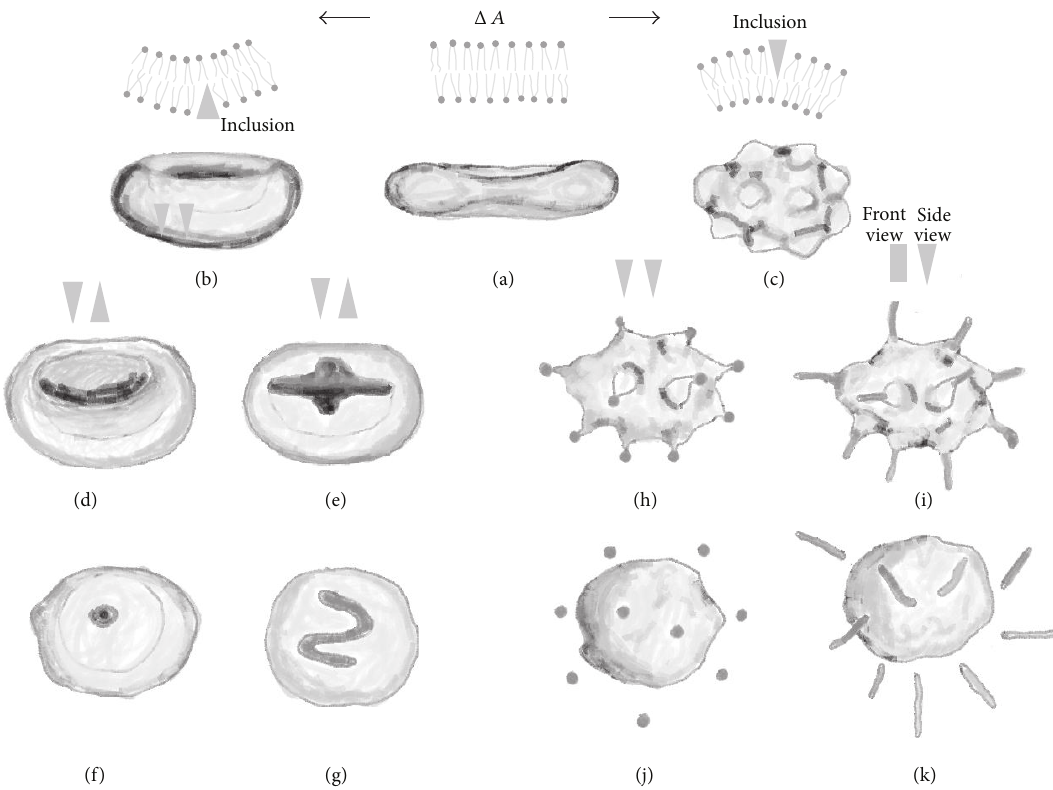
Figure 4: Suggested mechanism of erythrocyte shape change due to continuous interaction of exogenous substance with the membrane. Initially discocytic shape (a) transforms due to inclusions seeded by exogenous substance. If the inclusion resides in the outer layer, the area oftheouterlayerexpandsrelativelytotheareaoftheinnerlayer(thedifferencebetweentheareasoftheouterandtheinnerlayer Δ𝐴 increases) andthemembranewrinklesoutwardstoattainechinocyticshape(c).Iftheinclusionintercalatesintotheinnerlayer,theareaoftheinnerlayer expands relatively to the area of the outer layer ( Δ𝐴 decreases) and the membrane bends inwards to attain stomatocytic shape (b). The process is promoted by increasing the number of inclusions while the erythrocyte shape transformation depends on the shape of the inclusion. If the inclusion is isotropic (axisymmetric with respect to the axis perpendicular to the membrane surface) and favors strongly curved membrane regions, membrane buds that form on the tips of the echinocyte spicules have spherical shape (h) while the invagination of the stomatocyte is axisymmetric with respect to the geometrical axis of the cell (d). If the inclusion is anisotropic (nonaxisymmetric with respect to the axis perpendicular to the membrane surface, so that its front view differs from its side view) and favors strongly curved cylindrical membrane regions, the membrane buds that form on the tips of the echinocyte spicules have tubular shape (i), while the invagination of the stomatocyte attains a peculiar pocket-like shape (e). The process of shape transformation is reflected also in the shape of the pinched-off EVs which may be spherical (j) or tubular (k) or in the shape of erythrocyte inner structures hinted by the shape of the closure at the cell surface (f, g), depending on the shape of the inclusions and their preference for the outer/inner membrane